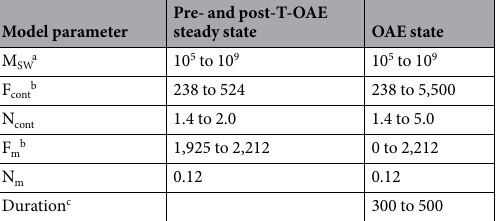
Table 1. Range of parameters explored modelling the osmium isotope excursion associated with the Toarcian Oceanic Anoxic Event in the East Tributary and Yorkshire sections. a Reservoir unit is mol Os. b Flux units are mol/yr Os. c Duration unit is kiloyear